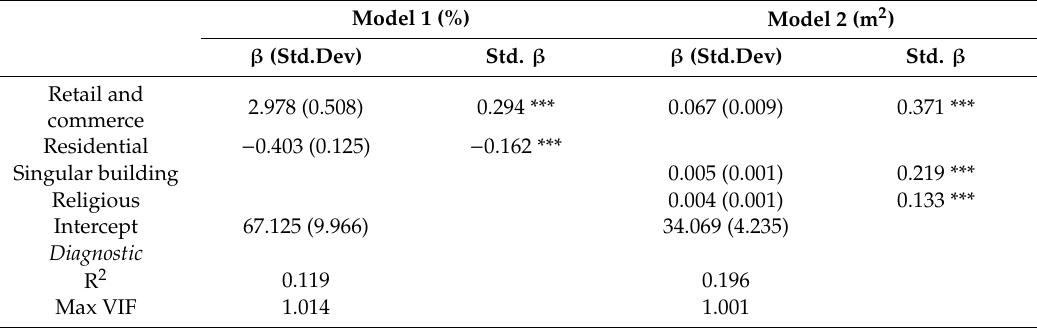
Table 7. Stepwise Ordinary Least Square (OLS) regressions with percentage of land uses per street segment (model 1) and with the number of m 2 of land uses per street segment (model